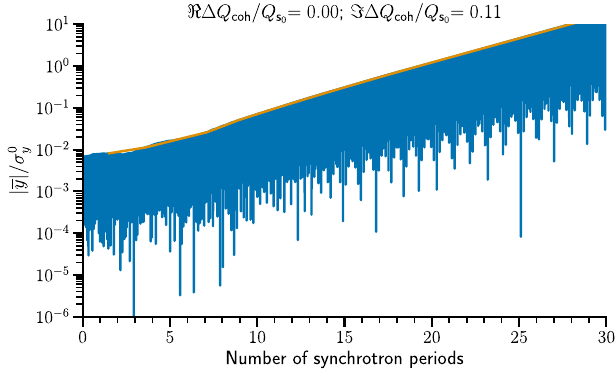
FIG. 3. Example from an instability simulation: the beam offset evolution over several synchrotron periods (blue). The exponen- tial fit (orange) delivers the resulting growth rate.